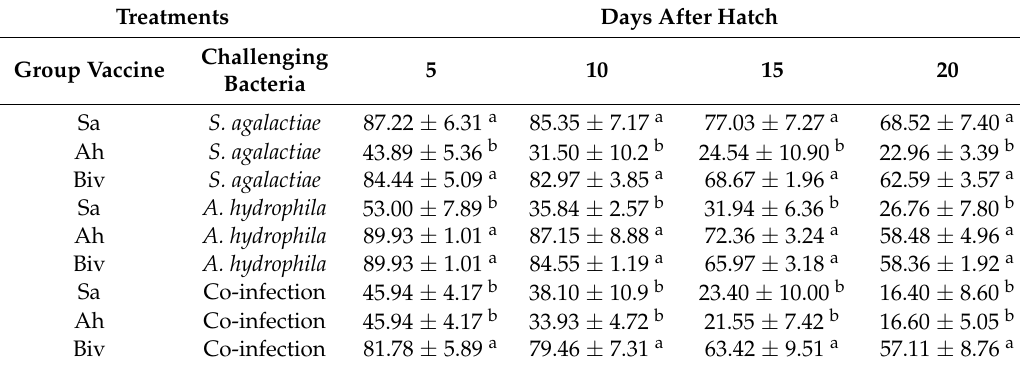
Table 1. Relative percent survival of offspring produced from the Sa, Ah, and Biv group after being challenged with Streptococcus agalactiae , Aeromonas hydrophila , and coinfection at larvae aged 5, 10, 15, and 20 days after hatch. Treatments Days After